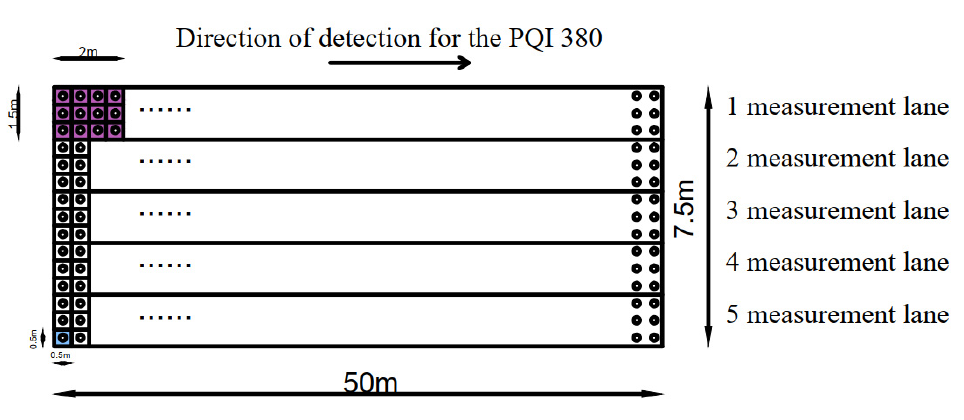
Figure 11. GPR detection distribution map.